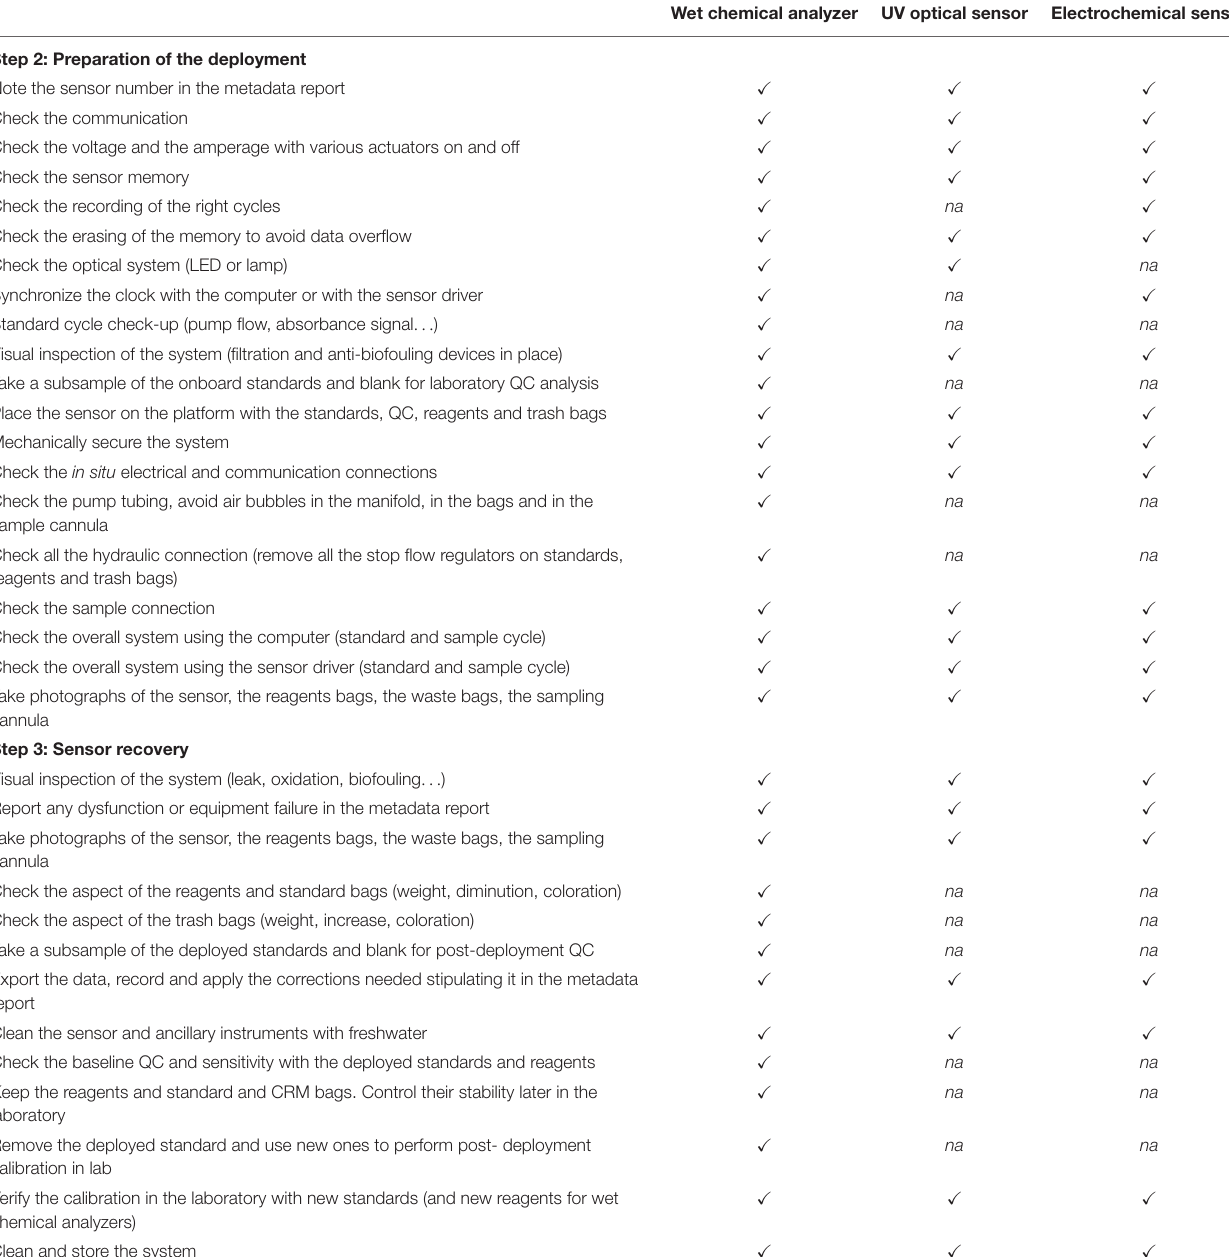
TABLE 3 | Example of a technical check-list to conduct during the deployment of in situ nutrient sensors (to evaluate (cid:88) , not applicable na ). Wet chemical analyzer UV optical sensor Electrochemical